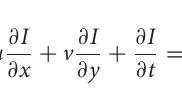
Frontiers in Psychology |